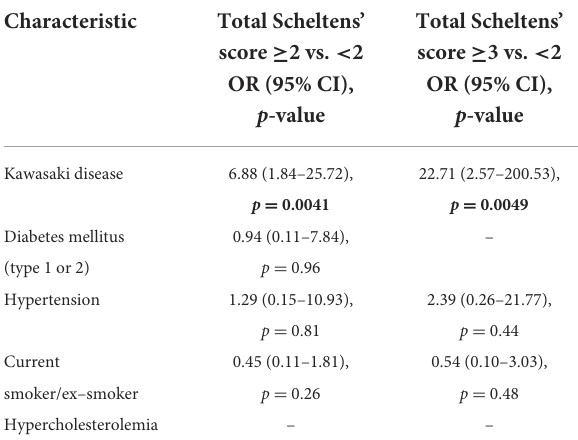
TABLE 2 Risk factors total Scheltens’ score ≥ 2 vs. < 2 and ≥ 3 vs. < 2 with binary logistic